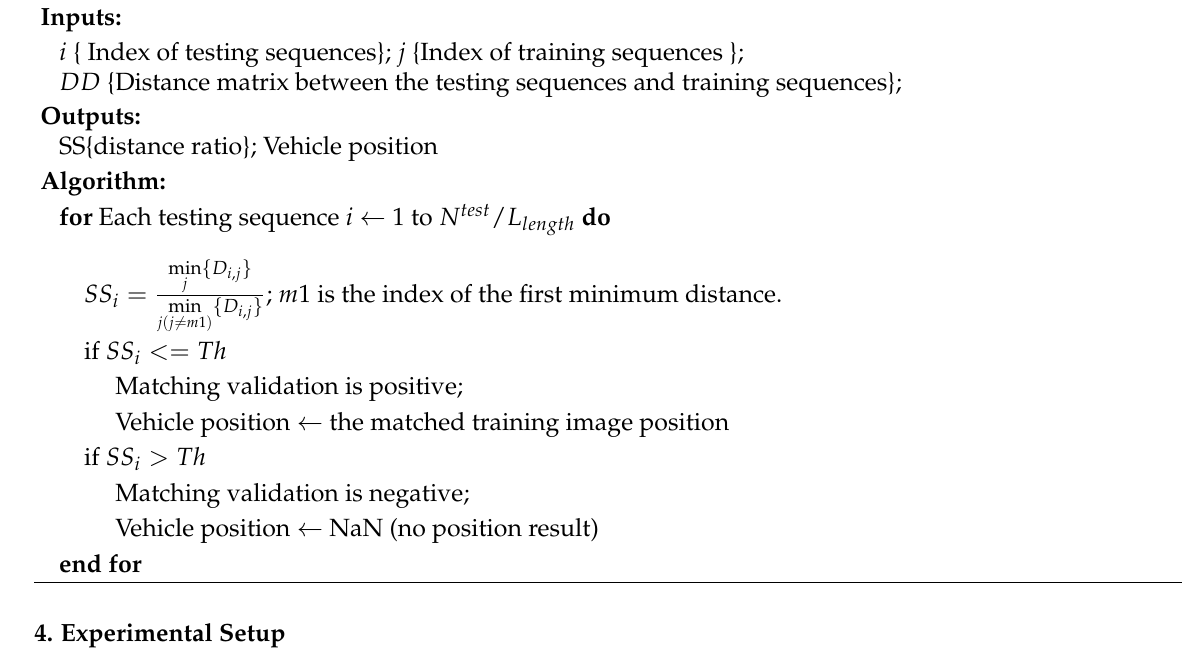
Algorithm 2 Sequence matching validation and visual